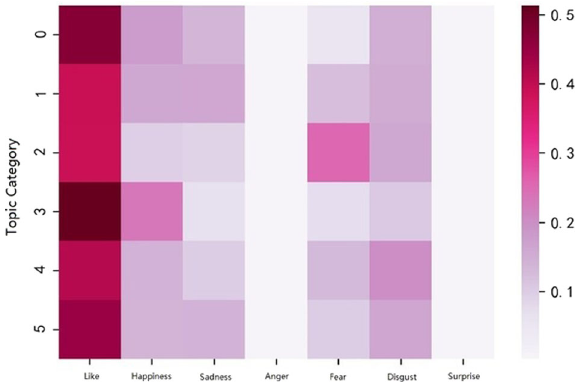
Fig. 7 Emotion distributions in different topic categories. The comparison of emotion distributions by